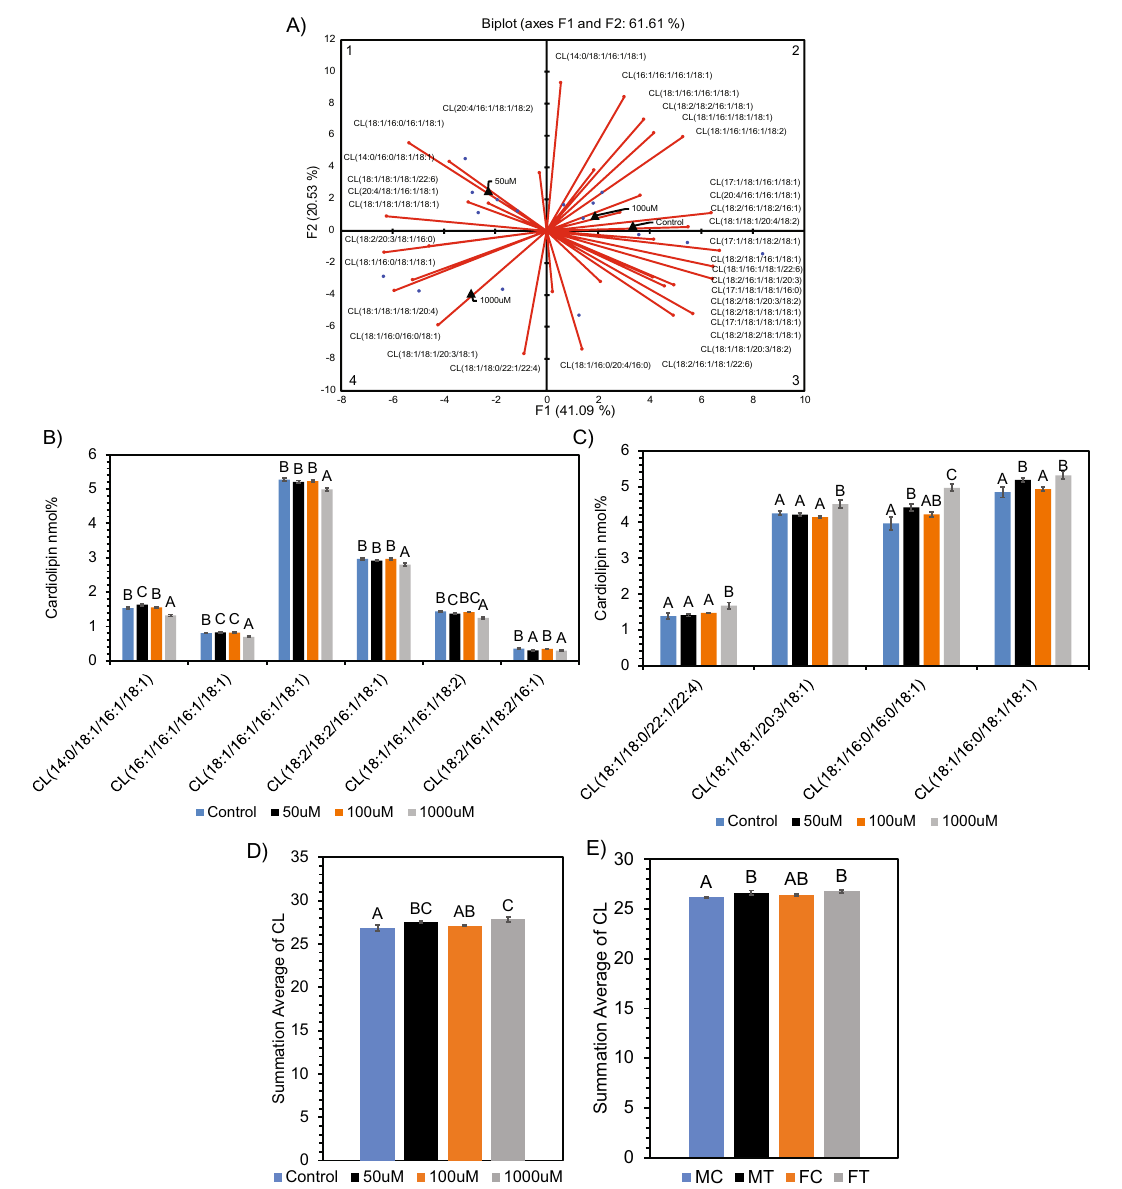
Figure 3. Alteration in cardiolipin (CL) composition after SCFA treatment. ( A ) PCA biplot showing relationship between SCFA treatment and cardiolipin molecular species. ANOVA revealed significantly (p < 0.05) altered CL molecular species in quadrant 2 ( B ), quadrant 4 ( C ) of the PCA. Average sum of all ANOVA significant (p < 0.05) CL species altered in ( D ) neuronal cells and ( E ) Long Evans rat brain. Species determined by PCA and Differential Expression, respectively, prior to ANOVA. Bar charts representative of means ± standard error. Means represented by different superscripts are significantly different at p <